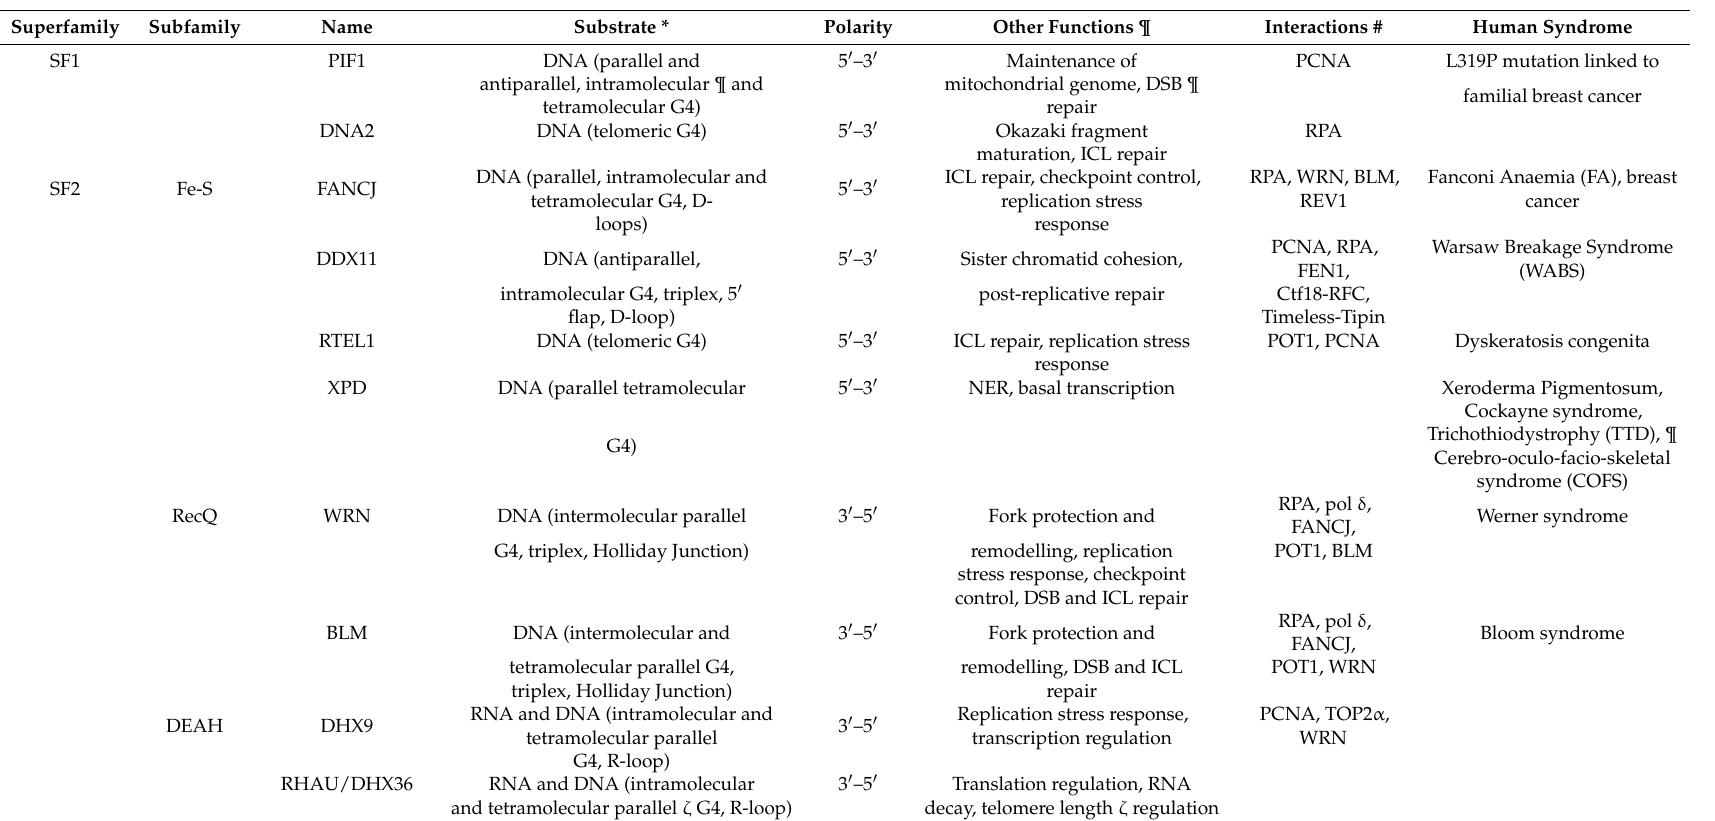
Table 1. Summary of the G4 processing helicases discussed in this